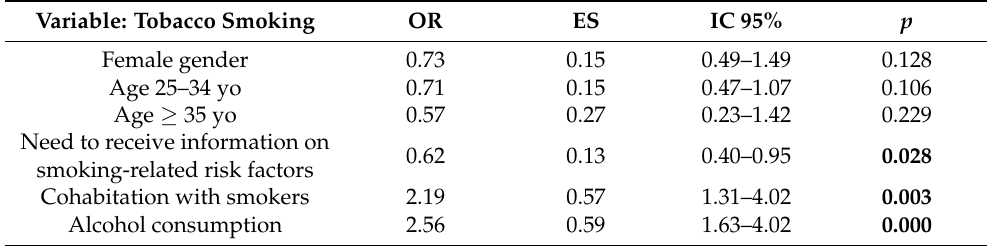
Table 2. Multiple logistic regression